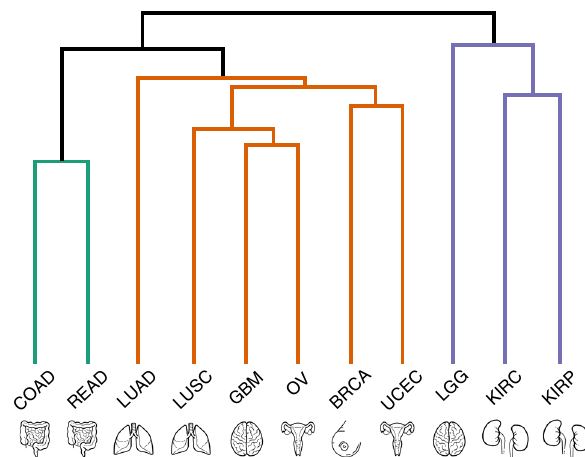
Fig. 1 Tumour clustering. Tumour dendrogram according to the hierarchical clustering of 760-gene z -scores fi ltered by CLR algorithm. Brain, lung, intestine, uterus, and kidneys icons made by Kirill Kazacheck (https:// www. fl aticon.com/authors/kirill-kazachek) and breast icon made by Freepik (https://www. fl